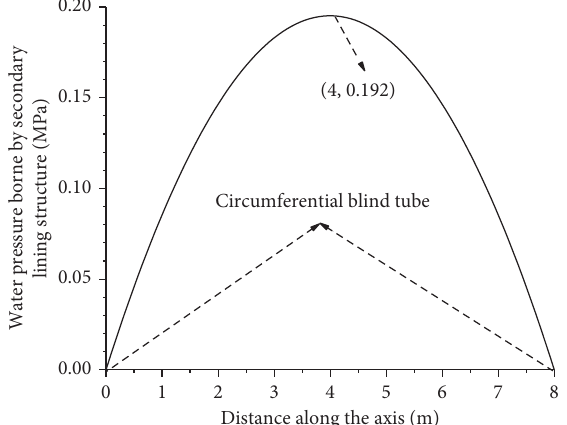
Figure 14: Seepage pressure borne by the secondary lining structure.